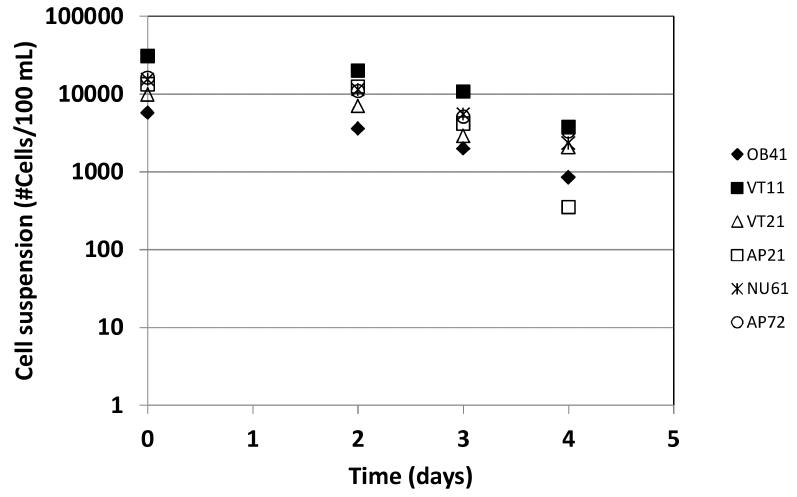
Figure 2. Results of bacteria survival